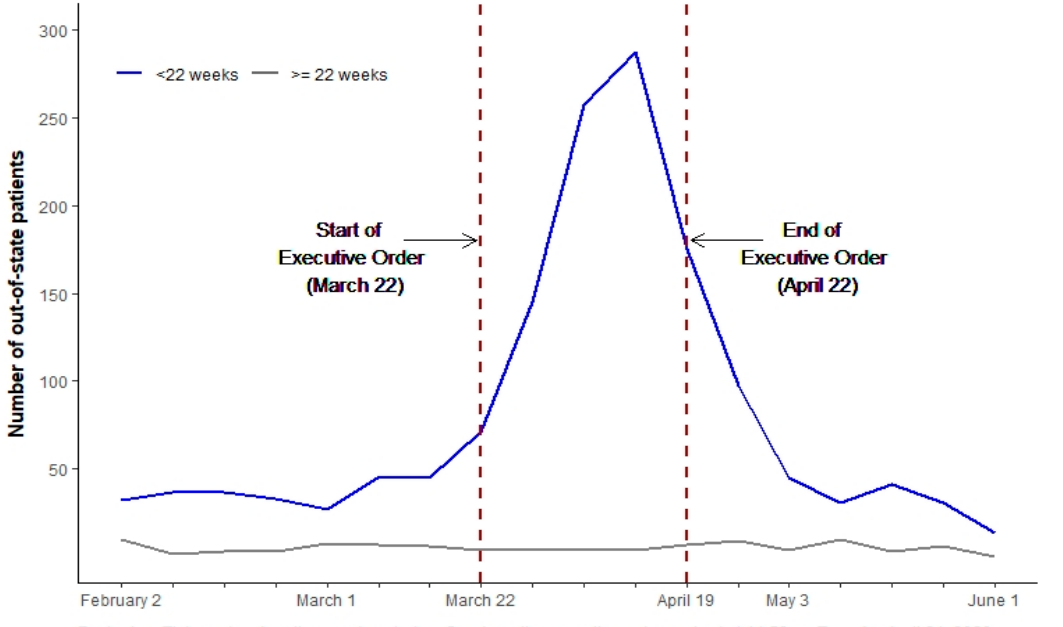
Figure 2. Weekly volume of Texas residents obtaining out-of-state abortion care, by gestational duration.